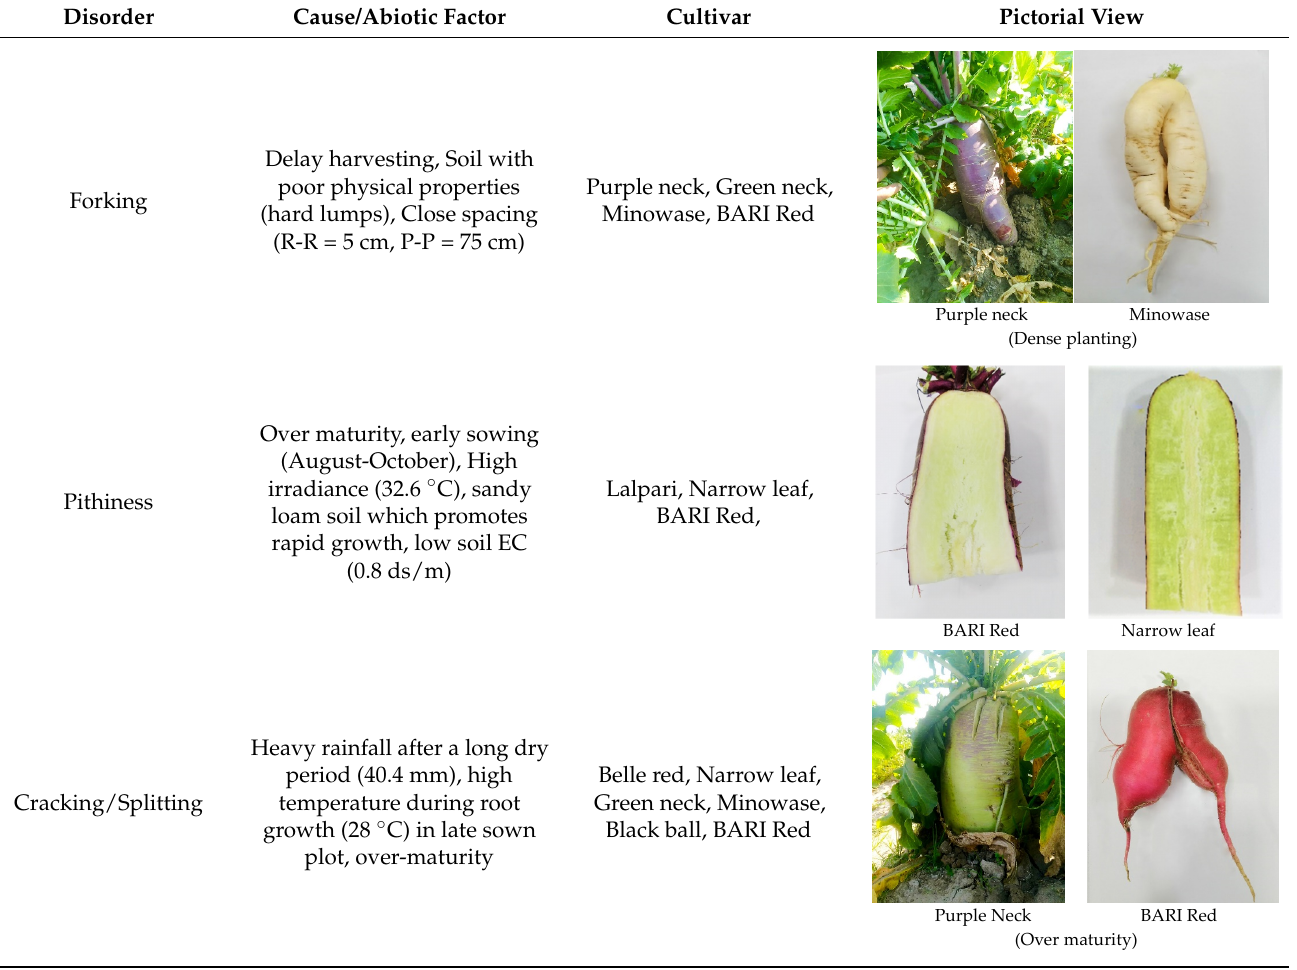
Table 2. Abiotic factors induced different physiological disorders in various cultivars of radish. Disorder Cause/Abiotic Factor Cultivar Pictorial View